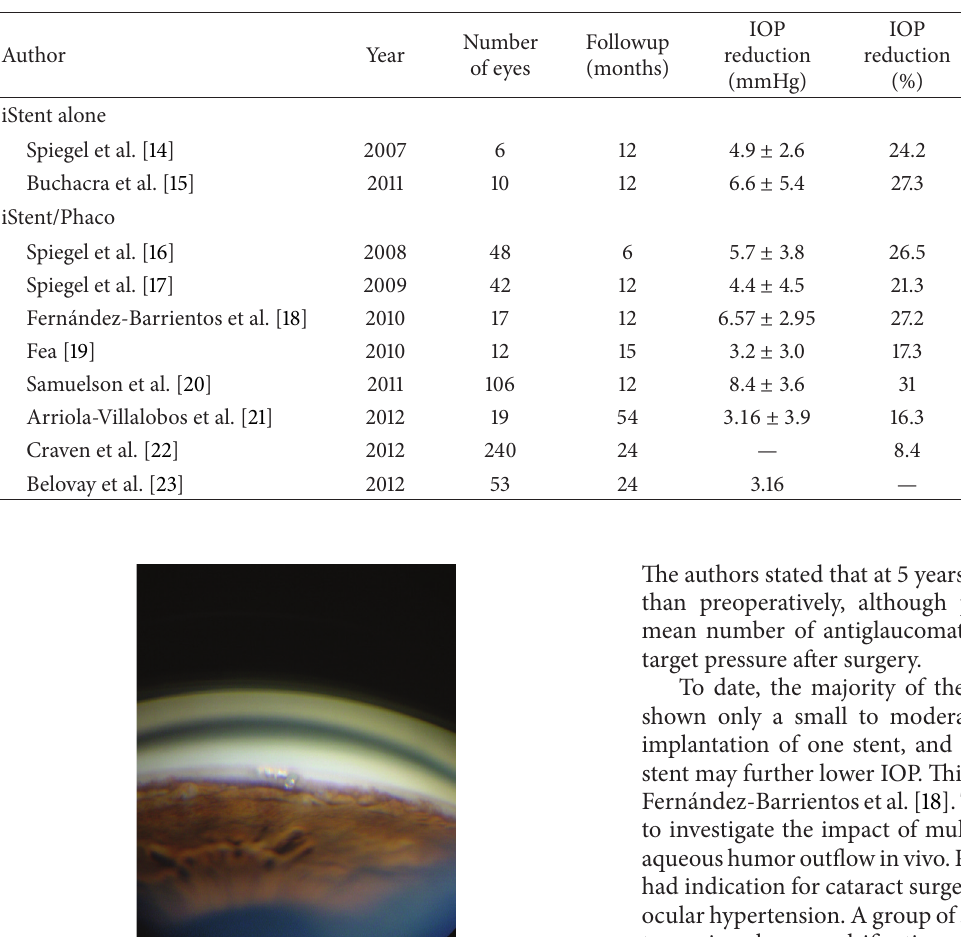
Table 5: Microbypass stent studies results.